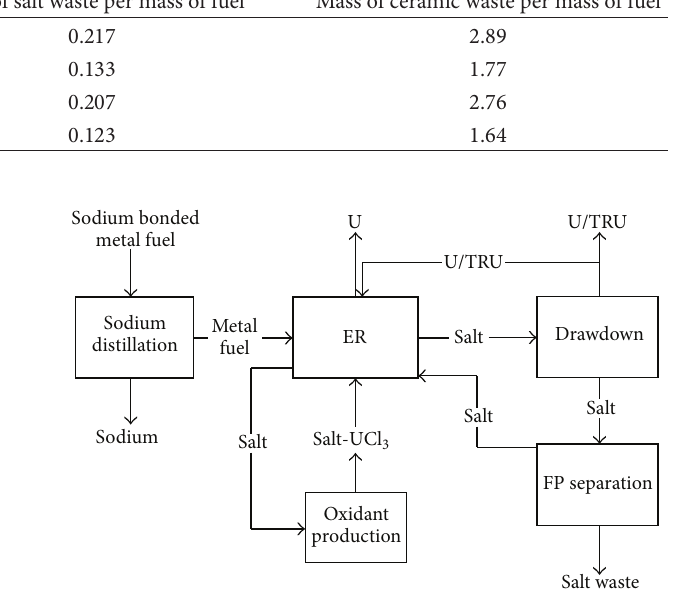
Figure 3: Used metal fuel pyroprocessing flowsheet involving selec- tive separation of actinides and fission products from electrorefiner